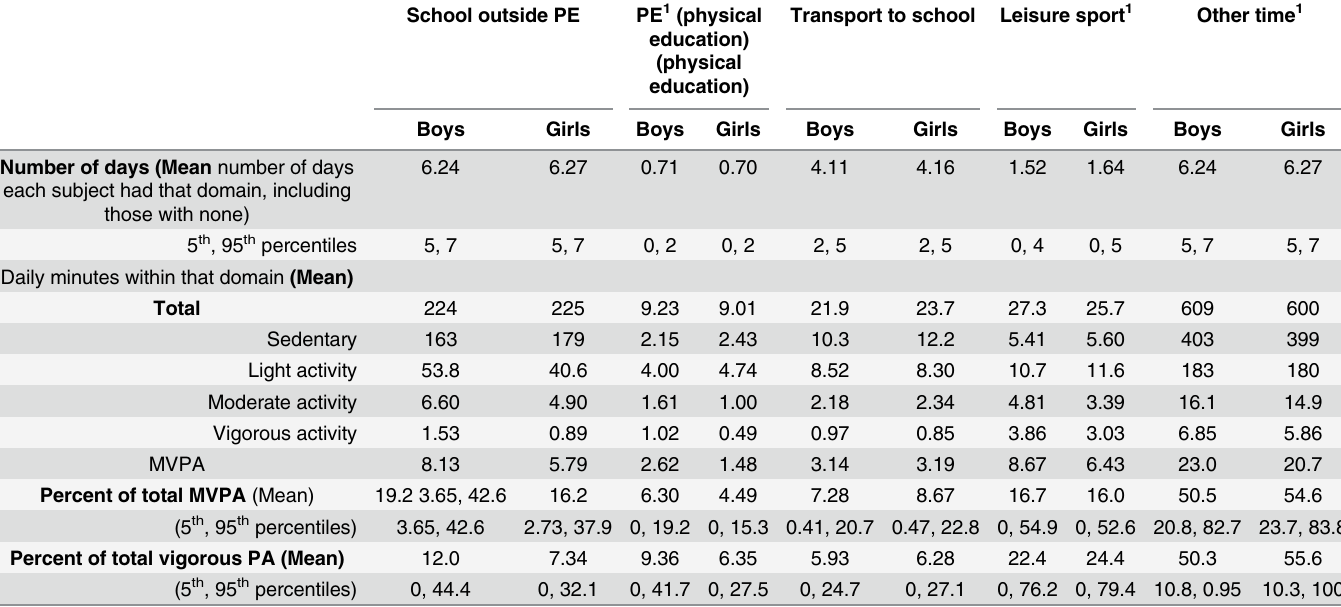
Table 4. Activity Allocation by Domain, All